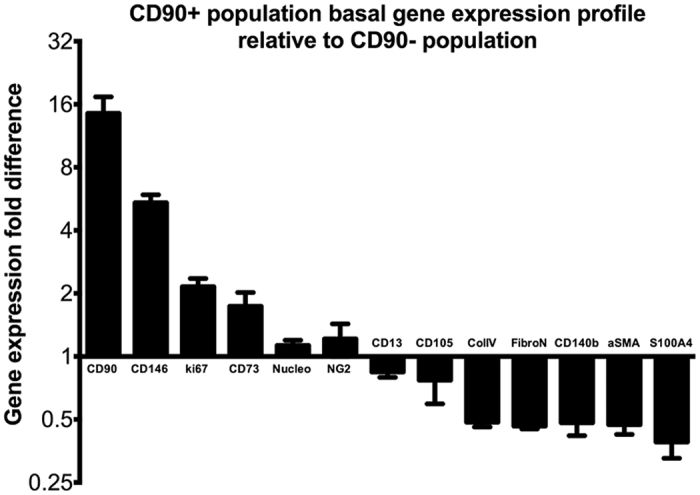
Gene expression profile of mesenchymal, pericyte and extra-cellular matrix protein genes in the CD90+ population relative to levels observed in the CD90− population.Graph illustrates the gene expression profile of the CD90+ population in reference to the CD90− population. qRT-PCR data from 5 separate experiments from 4 different cases have been compiled in the above data. CD90+ population consistently showed greater than two fold higher expression of mesenchymal marker genes CD90, CD146, CD73 and cellular proliferation marker ki67. Conversely, the CD90− population showed greater than two fold higher expression of extracellular matrix and stress-fiber genes such as collagen IV, fibronectin, αSMA and mature pericyte/fibroblast markers CD140b and S100A4.